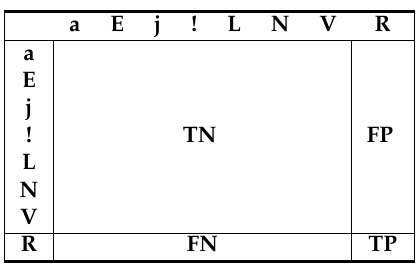
Table 11. Examples of how to compute TP, TN, FP, and FN of class “R”.